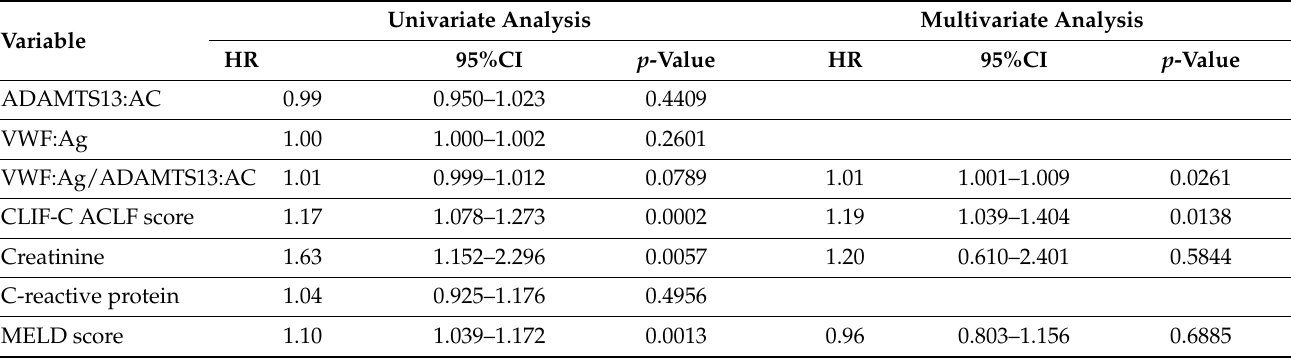
Table 3. The association of patient characteristics and